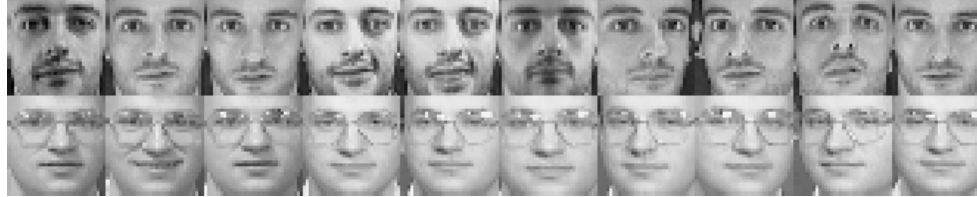
Figure 10. The typical images of the ORL face dataset.